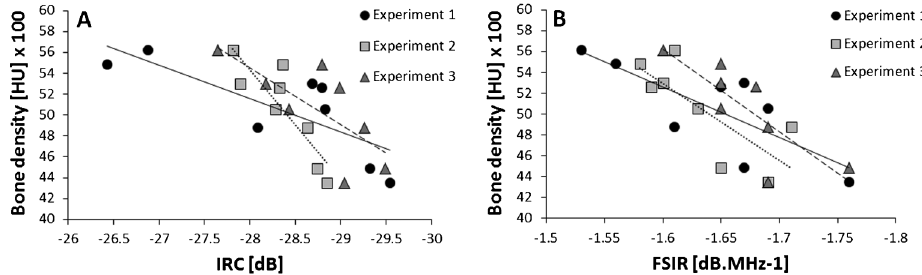
Figure 4. Pearson’s correlation between surface bone density, the integrated reflection coefficient (IRC; A ) and frequency slope of integrated reflection (FSIR; B ) for three experiments. The experiment showed positive correlation between surface bone density and the parameter IRC (r=0.79, P=0.019; r=0.87, P=0.005; r=0.724, P=0.042), in Experiments 1, 2, and 3, respectively, and the parameter FSIR (r=0.78; P=0.023; r=0.77; P=0.026; R=0.81; P=0.016), in Experiments 1, 2, and 3,